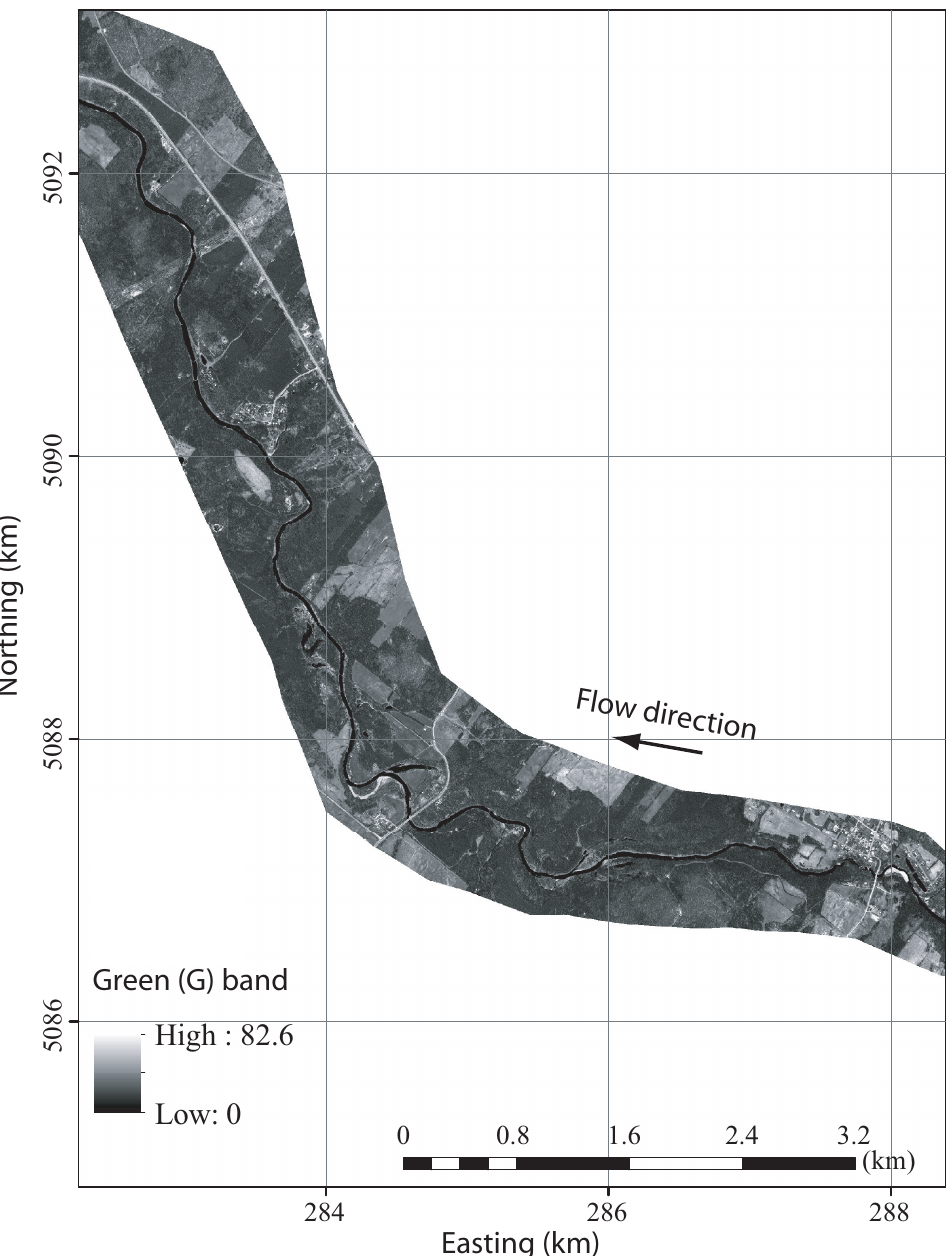
Figure A6. Corrected radiance in the green (G)